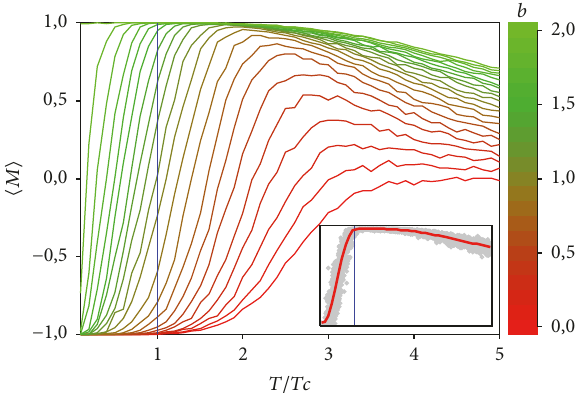
Figure 4: Ramping up to meet maximum flexibility. Each curve represents the final magnetisation for a pair of (𝑇,𝑏) reached from a starting configuration with all spins down ( 𝑀 = −1 ). The inset shows the curve for 𝑏 = 1.5 (grey dots are numerical realisations and red line represents the averaged value) and the critical temperature (blue vertical